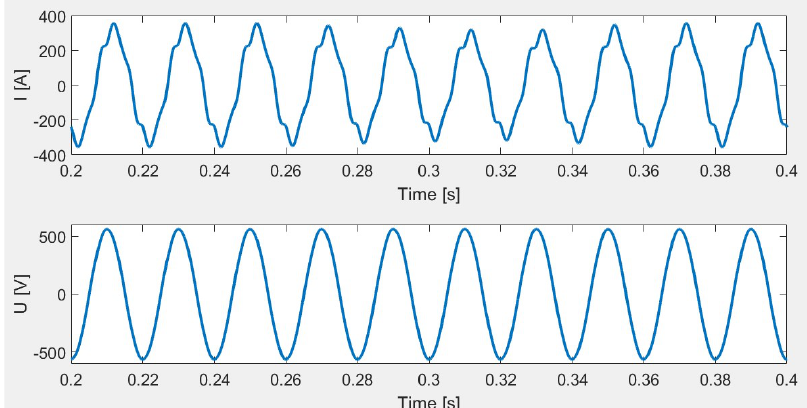
Figure 11. Voltage and current of the transformer supplying seven 22 kW AC chargers.